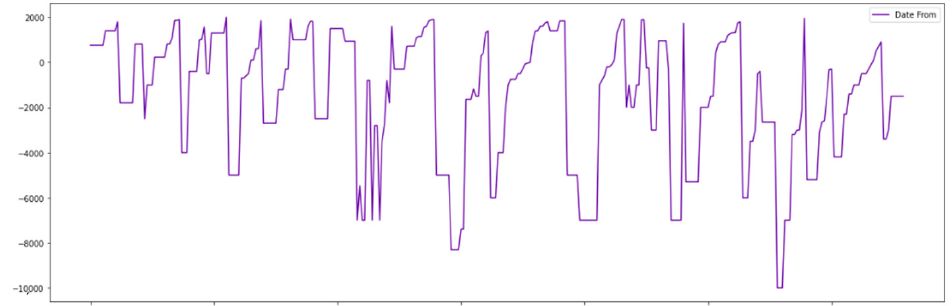
Figure 5. Shows the soil moisture of the Godavari Plateau